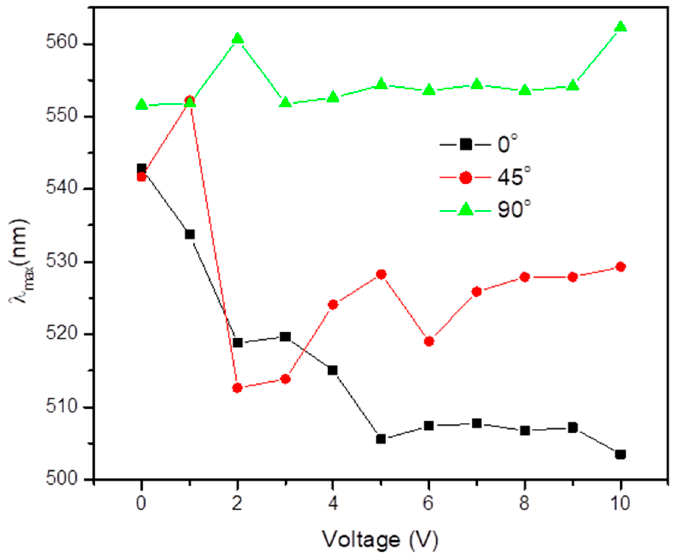
Figure 2. Optical absorption peak wavelength against a wide voltage range of an external applied electric field at 0°, 45° and 90° angles between the incident polarized light and the rubbing direction. Reproduced with permission from Ref. [44]. (Optical Society of America).